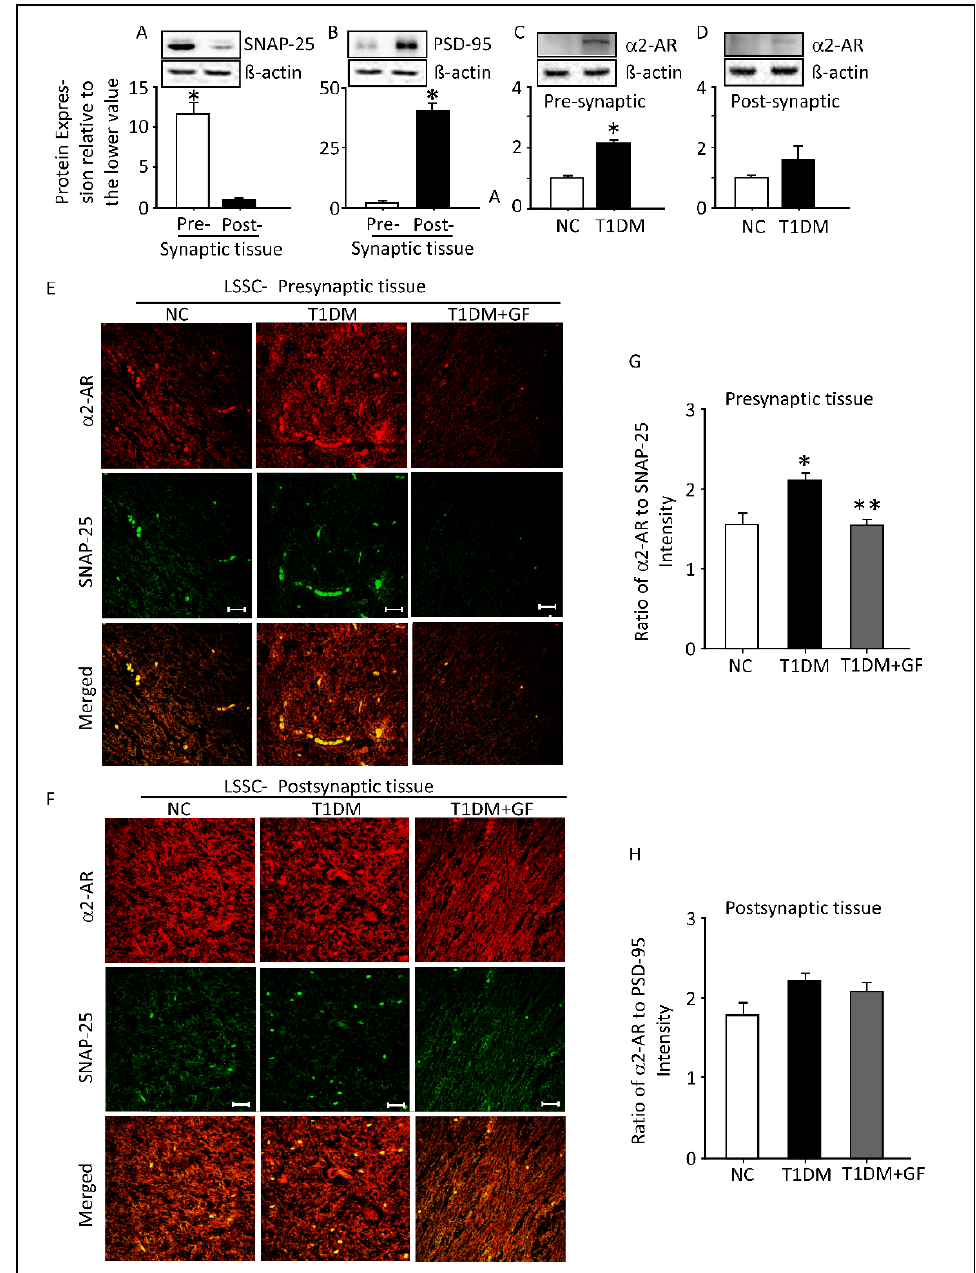
Figure 6. Expression of α 2 ‐ AR in the pre ‐ synaptic and post ‐ synaptic fractions of the spinal cord Figure 6. Expression of α 2-AR in the pre-synaptic and post-synaptic fractions of the spinal cord lumbar region. The pre ‐ /post ‐ synaptic fractionation protocol was verified by Western blot using lumbar region. The pre-/post-synaptic fractionation protocol was verified by Western blot using antibodies directed against the pre ‐ synaptic SNAP ‐ 25 ( A ) and post ‐ synaptic PSD ‐ 95 ( B ) protein antibodies directed against the pre-synaptic SNAP-25 ( A ) and post-synaptic PSD-95 ( B ) protein marker. Diabetes upregulates pre ‐ synaptic ( C ) but not post ‐ synaptic ( D ) spinal α 2 ‐ AR proteins. Im ‐ marker. Diabetes upregulates pre-synaptic ( C ) but not post-synaptic ( D ) spinal α 2-AR proteins. munofluorescence localization of pre ‐ synaptic ( E ) and pos ‐ synaptic ( F ) α 2 ‐ AR in control, diabetic Immunofluorescence localization of pre-synaptic ( E ) and pos-synaptic ( F ) α 2-AR in control, diabetic and diabetic treated with guanfacine for two weeks. Fluorescence intensity of α 2 ‐ AR relative to SNAP ‐ 25 ( G ) and PSD ‐ 95 ( H ). Protein bands imaged with the ChemiDoc TM MP were analyzed using and diabetic treated with guanfacine for two weeks. Fluorescence intensity of α 2-AR relative to SNAP- Image Lab software. Each bar represents the mean ± SEM of values obtained from five ani ‐ 25 ( G ) and PSD-95 ( H ). Protein bands imaged with the ChemiDoc TM MP were analyzed using Image mals/group. * Significantly different from corresponding or control values at p ≤ 0.05. ** Significantly Lab software. Each bar represents the mean ± SEM of values obtained from five animals/group. different from corresponding diabetic values at p ≤ 0.05. Representative confocal images at magni ‐ * Significantly different from corresponding or control values at p ≤ 0.05. ** Significantly different fication: 40X and scale bar: 20 μ m. Abbreviations: NC, normal control; T1DM, Type 1 Diabetes Melli ‐ from corresponding diabetic values at p ≤ 0.05. Representative confocal images at magnification: tus; GF, guanfacine; α 2 ‐ AR, alpha ‐ 2A adrenoceptors; LSSC, lumbar segment of the spinal cord; 40X and scale bar: 20 µ m. Abbreviations: NC, normal control; T1DM, Type 1 Diabetes Mellitus; GF, SNAP ‐ 25, synaptosomal ‐ associated protein ‐ 25; and PSD ‐ 95, postsynaptic density ‐ 95. guanfacine; α 2-AR, alpha-2A adrenoceptors; LSSC, lumbar segment of the spinal cord; SNAP-25, synaptosomal-associated protein-25; and PSD-95, postsynaptic